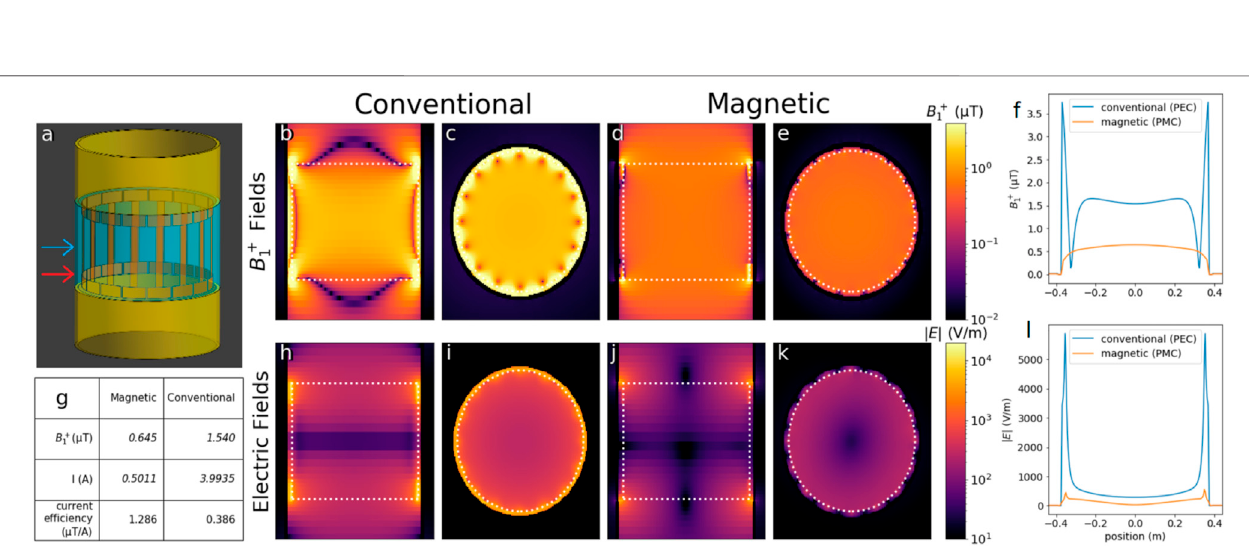
Frontiers in Physics |